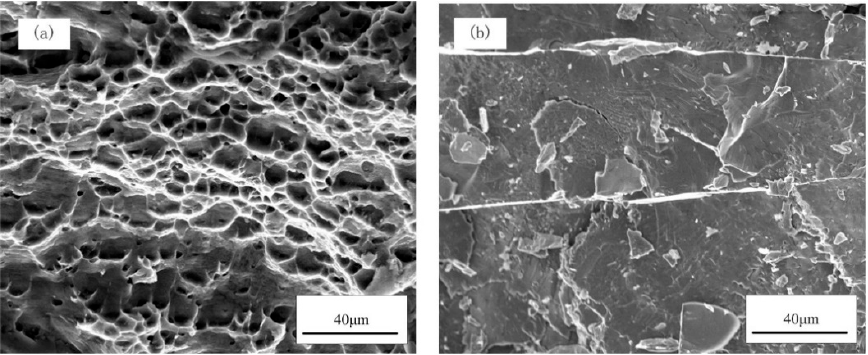
Figure 15. SEM fractography of the ruptured specimens: ( a ) fractured at weld seam, ( b ) detached between galvanized steel and brazed seam interface.